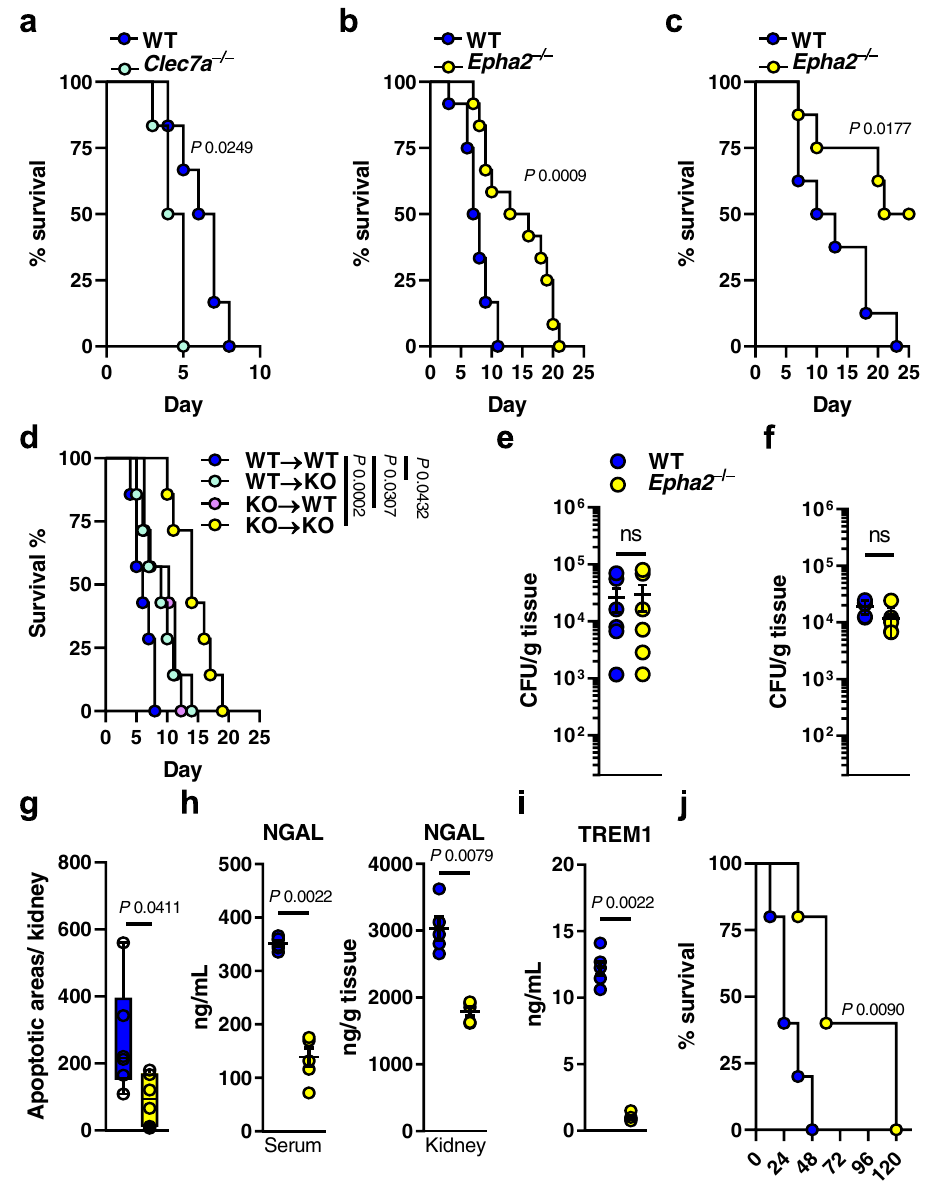
Fig. 1 | EphA2 promotes disease progression during disseminated candidiasis. a Survival of wild-type and Dectin-1 – / – (Clec7a – / – ) mice infected intravenously with 2.5×10 5 SC5314 C.albicans . N =6;combineddataoftwoindependentexperiments. N =12; combined data of two independent experiments) or 1.25×10 5 ( c ; N